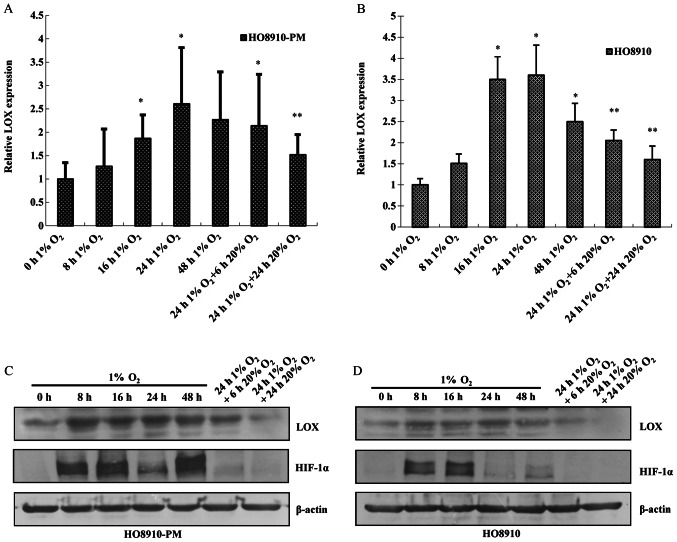
Hypoxia increases the expression of LOX and HIF-1α in ovarian cancer cells. Cells were cultured in hypoxia for 8, 16, 24 or 48 h, or hypoxia followed by reoxygenation, as indicated. Quantitative RT-PCR of LOX mRNA expression in (A) highly invasive/metastatic HO8910-PM ovarian cancer cells and (B) poorly invasive HO8910 ovarian cancer cells; the expression of LOX was normalized to GAPDH and expressed relative to cells cultured in 20% O2. Western blots of LOX and HIF-1α protein expression in (C) HO8910-PM and (D) HO8910 cells; β-actin was used as a loading control. *P<0.05 vs. control cells cultured in 20% O2; **P<0.05 vs. cells cultured in 1% O2, ANOVA.